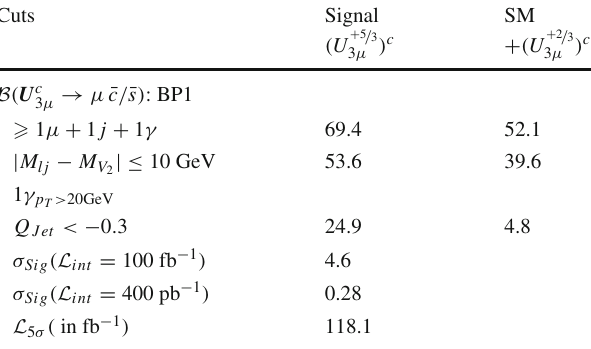
Table 11 Number of events after the cumulative cuts for the vector √ s = 318 . 12 GeV and L int = 100 fb − 1 triplet leptoquark U c at 3 μ